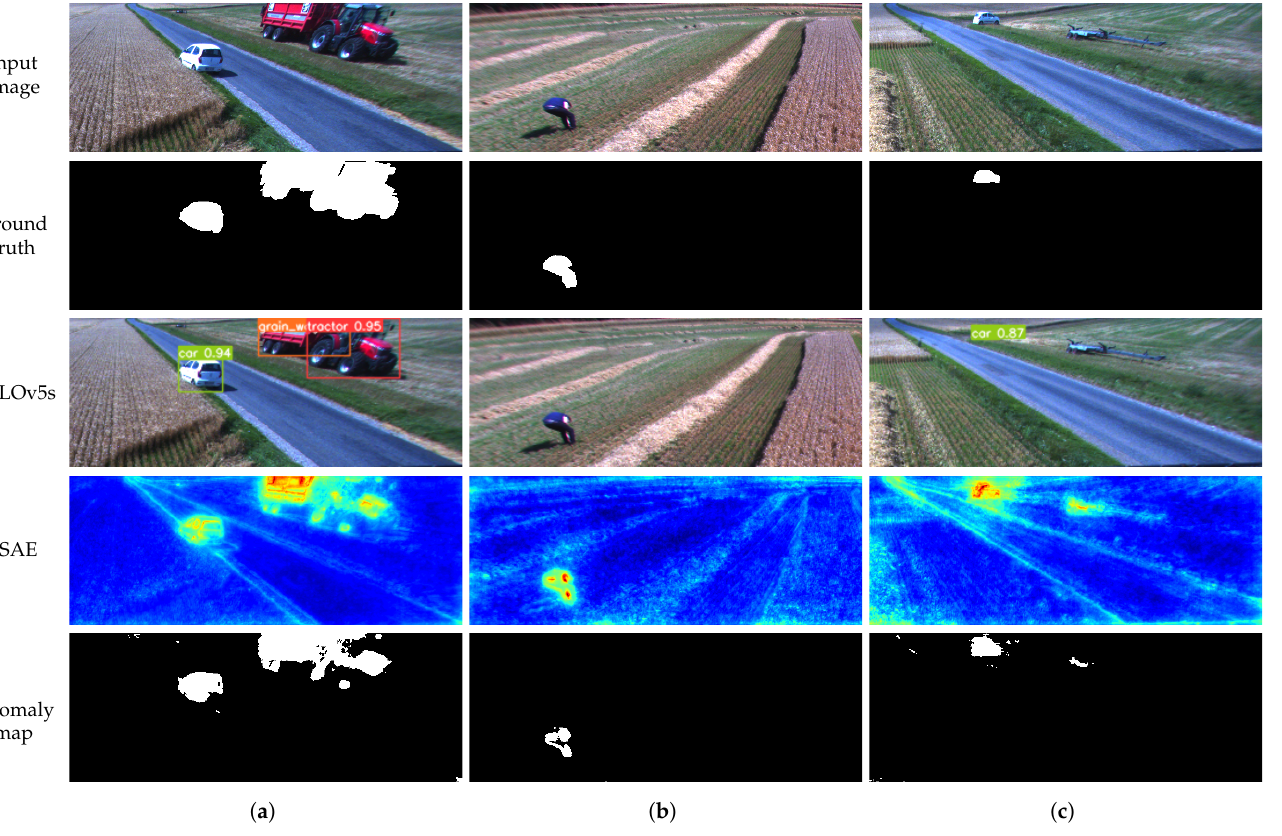
Figure 7. Detection examples. ( a ) Object detector and autoencoder detect objects in the image; ( b ) object detector fails to detect a human; ( c ) autoencoder detects a car and an object that is not part of the annotated dataset, while the object detector detects only the car.